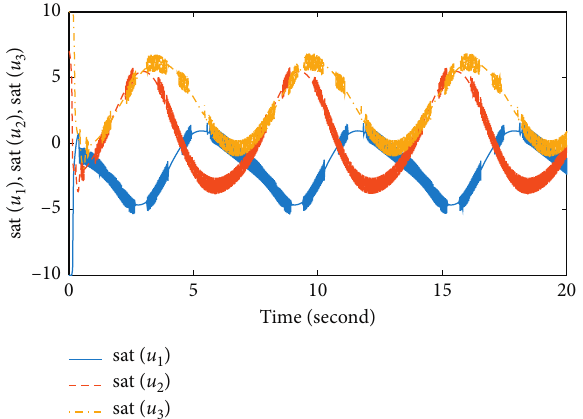
Figure 2: Case 1: the trajectories of sat ( u